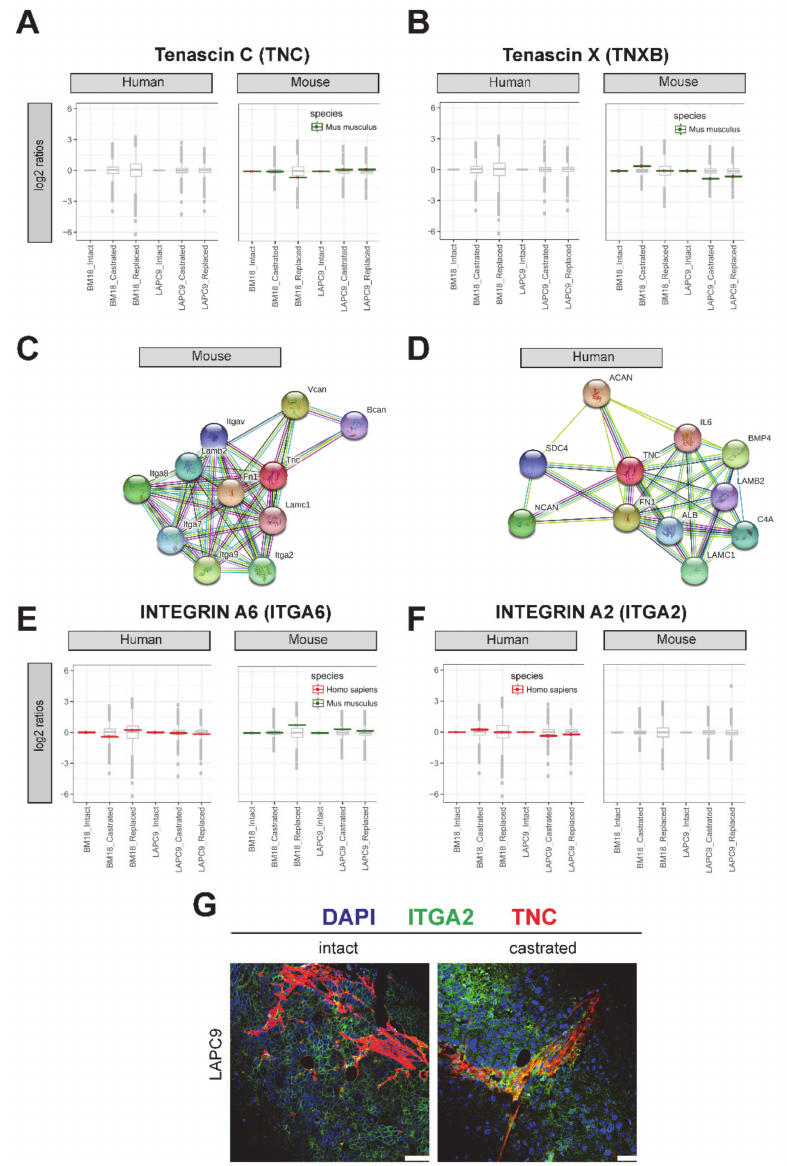
Figure 6. Tenascin C and its predicted interaction partners analyzed by mass spectrometry. ( A ) Tenascin C (TNC) and ( B ) alternative isoform Tenascin X (TNXB) protein relative abundance (log 2 ratios; single replicates per sample from a pool of n = 3 to 4) in human cell isolations (left) and present in mouse cell isolations (right). The variance stabilization normalization (vsn)-corrected TMT reporter ion signals were normalized by the intact conditions of either BM18 or LAPC9. The protein sequences were predicted as mouse-specific (green). ( C ) Protein interaction network of the mouse TNC protein based on the STRING association network (https: // string-db.org / ). ( D ) Protein interaction network of the human TNC protein based on the STRING association network https: // string-db.org / . ( E ) Predicted TNC-binding partner integrin A6 (ITGA6) was detected by mass spectrometry in both the human and mouse protein lysates and matching the organism-specific protein sequence based on the bioinformatics analysis (red for human and green for mouse). ( F ) Predicted TNC-binding partner integrin A2 (ITGA2) was detected by mass spectrometry, specifically in the human protein lysates, and matched the human-specific protein sequence. ( G ) Spatial localization of the Tenascin protein (TNC, indicated in red) and integrin A2 (ITGA2, green) assessed by immunofluorescent co-labeling in LAPC9 intact and castrated tumors. DAPI marks the nuclei. Scale bars: 50 µ